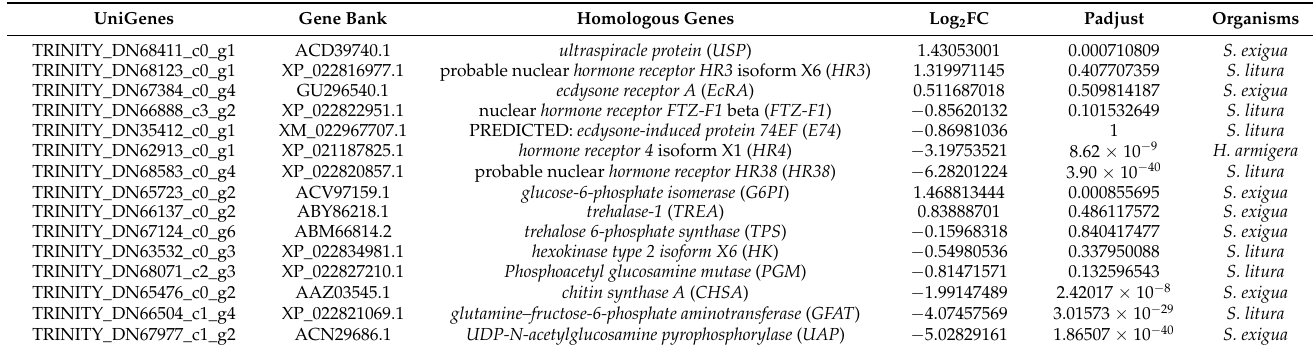
Table 2. Ecdysone signaling pathway of